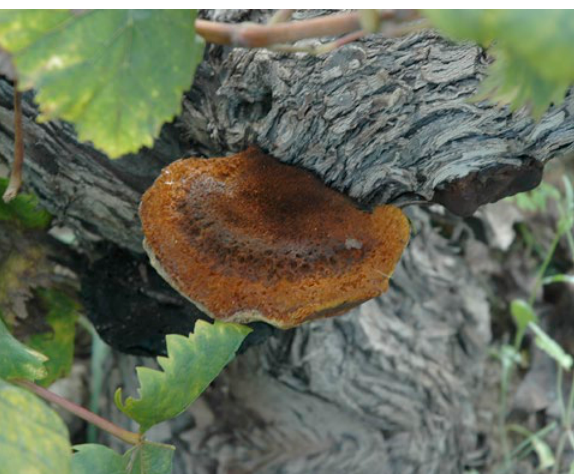
Figure 6. Fruitbody of Inonotus hispidus in one of the main wounds of a Vitis vinifera cv. “Moscatel Romano” plant stand. Photograph: V.